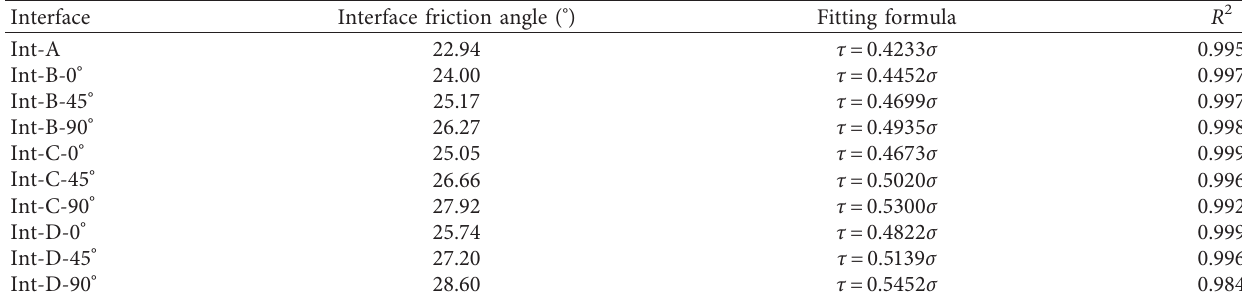
Figure 13: Relationship between normal stress and peak shear strength for steel-sand interfaces. (a) Int-A. (b) Int-B. (c) Int-C. (d) Int-D. Table 6: Interface friction angle and fitting